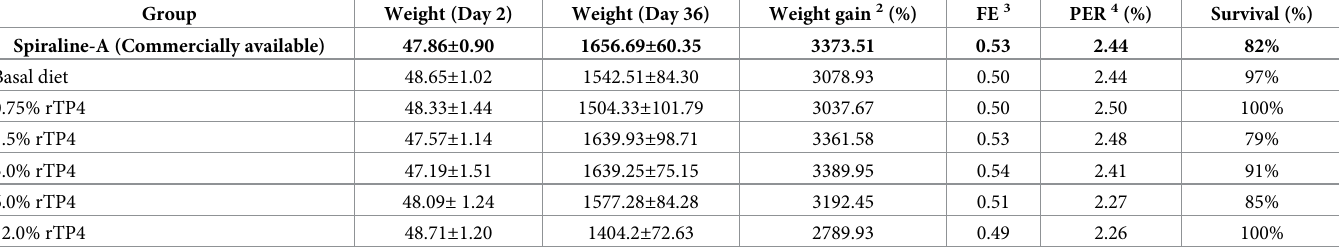
Table 2. Effect of weight gain ratio, feed efficiency (FE), protein efficiency ratio (PER) and survival rate of G . g . domesticus fed with diets containing rTP4 (0.75, 1.5, 3.0, 6.0 and 12%) spray-dried powder for 5 weeks1.